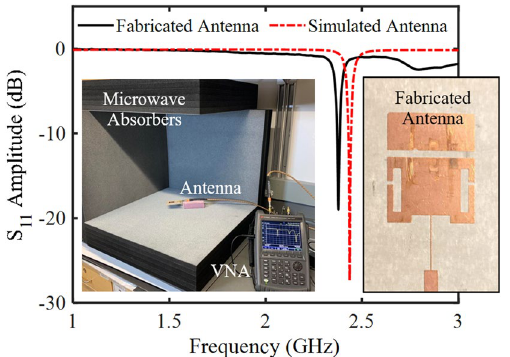
Figure 6. The S 11 response of the simulated and fabricated antenna along with the experimental setup used to make this measurement (left) and the fabricated patch antenna (right). Note that two microwave absorbers have been removed for the photo.